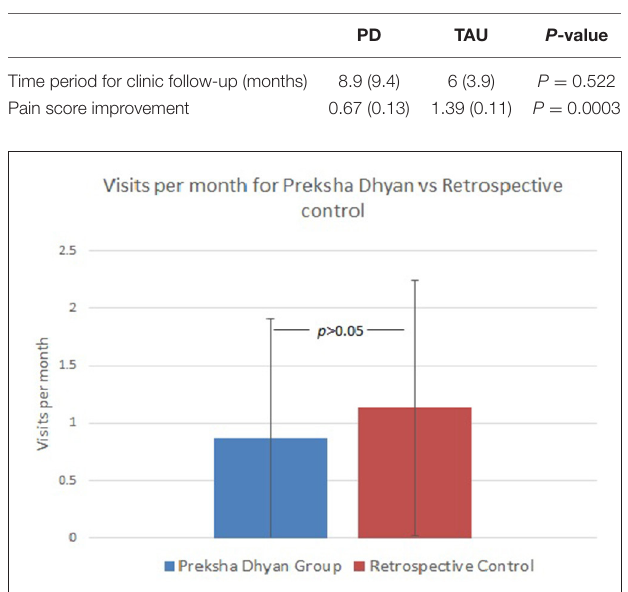
FIGURE 2 | Comparison of visits per month between Prekshya Dhyan and Retrospective Control.